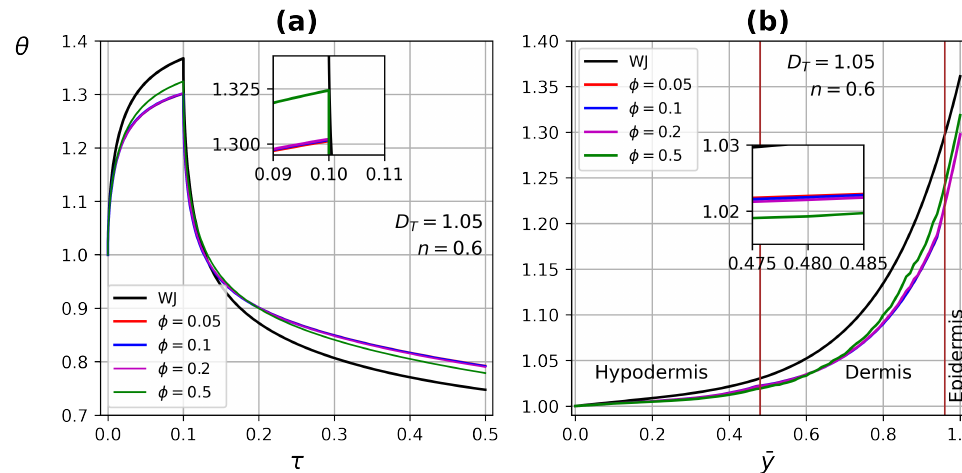
Figure 15. Temperature profiles as a function of ( a ) time and ( b ) tissue three-layer depth with different porosities, φ = 0, 0.5, and 0.05 for epidermis, dermis, and hypodermis,